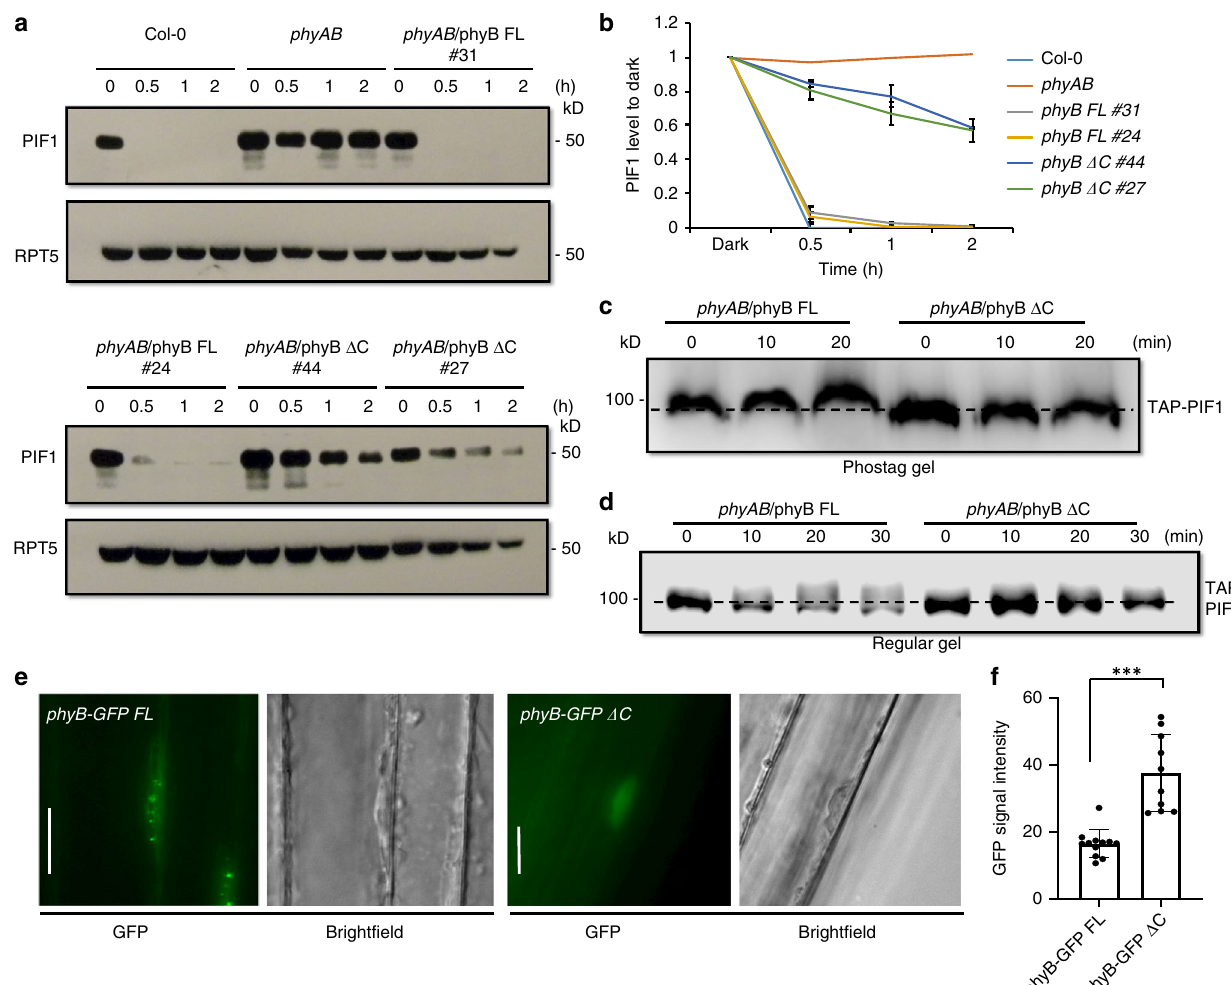
Fig. 6 The C-terminal SPA1-interaction domain of phyB is essential for photobody formation and PIF1 phosphorylation. a Immunoblots showing the level of native PIF1 in two independent transgenic lines of phyB-GFP FL (#31 and #24) and phyB-GFP Δ C (#44 and #27) along with wild type and phyAB as controls. Total protein was extracted from 4-day-old dark-grown seedlings either kept in darkness or exposed to continuous red light (3.5 μ molm − 2 s − 1 ) over time. b A graph showing the amount of PIF1 levels in response to red light exposure over time. c , d The light-induced phosphorylation of PIF1 is defective in phyB-GFP Δ C compared to phyB-GFP FL. e The phyB-SPA1 interaction is necessary for phyB nuclear transport and photobody formation. The phyB-GFP FL produces nuclear photobodies after 5 h of red light (10 µ molm − 2 s − 1 ) treatment (left), whereas phyB-GFP Δ C showed dispersed nuclear signals (right). Bar = 15 μ m. f The cytoplasmic GFP signals were quanti fi ed from phyB-GFP FL and phyB-GFP Δ C images by imageJ ( n = 12), Error bar = SD. *** p -value < 0.00001, student ’ s t